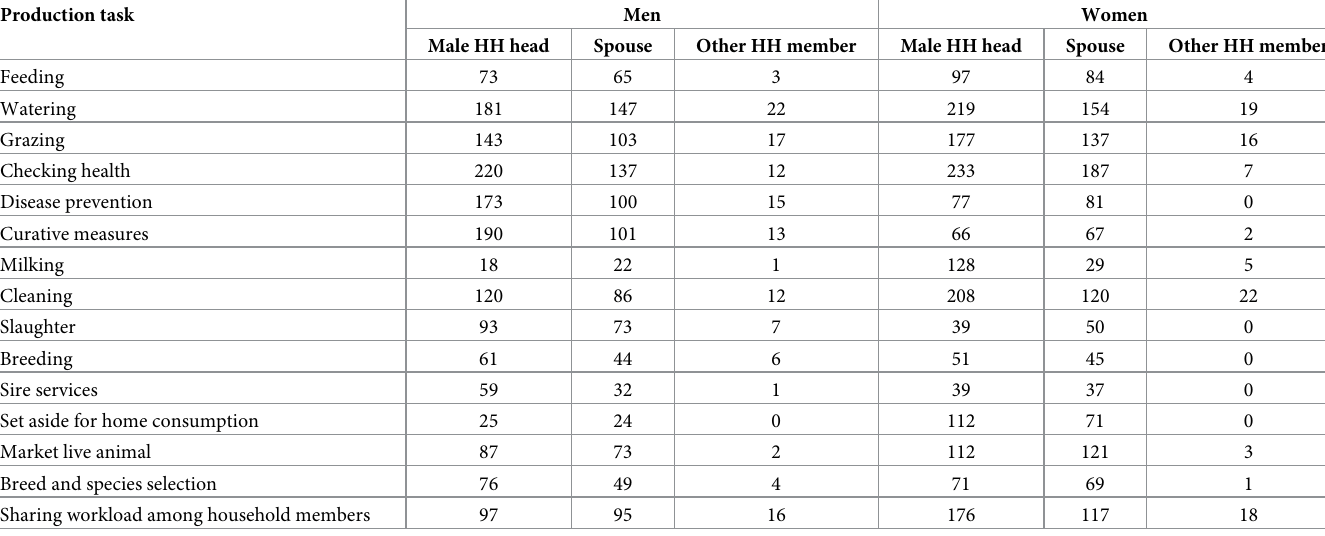
Table 7. Person responsible for decision making on different production